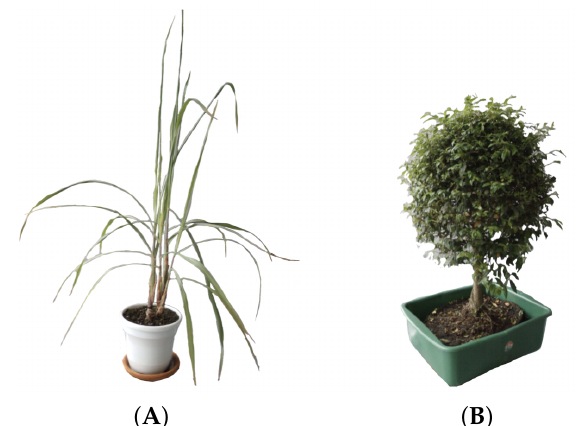
Figure 3. Plants used for the experimentation stages of this work: ( A ) The Limonaria ( Cymbopogon citratus ), ( B ) The Guaiacum bonsai ( Cuaiacum officinale